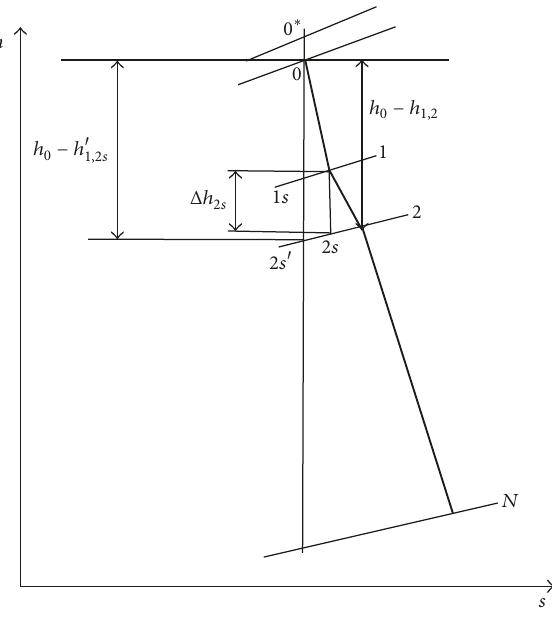
Figure 2: Turbine expansion process.